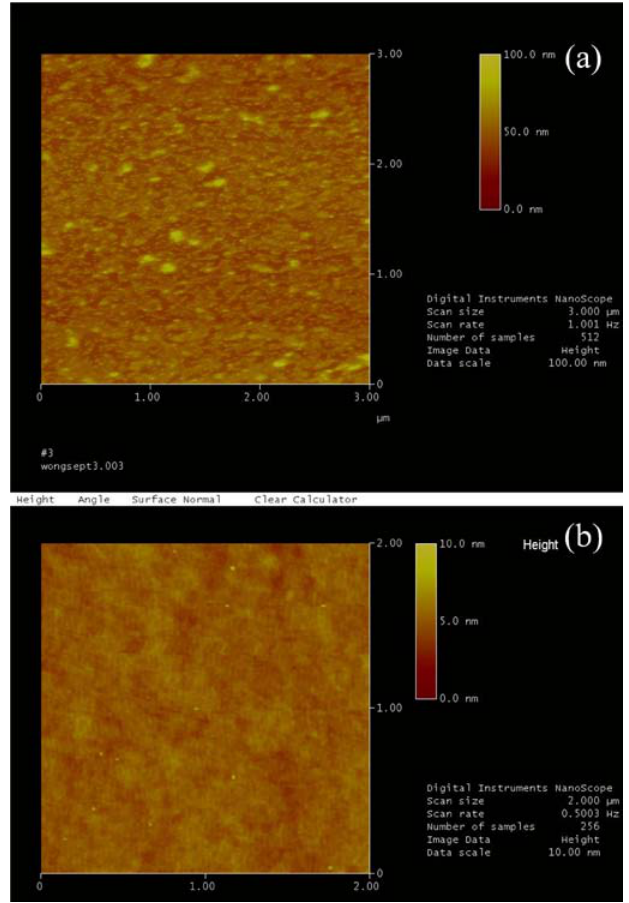
Figure 4. AFM images of end-face of (a) 12-bilayer PAH/AuNPs coated fiber probe with the 570 nm-attenuation valley in reflection spectrum, and (b) 20-bilayer PAH/AuNPs coated fiber probe without the 570 nm-attenuation valley in reflection